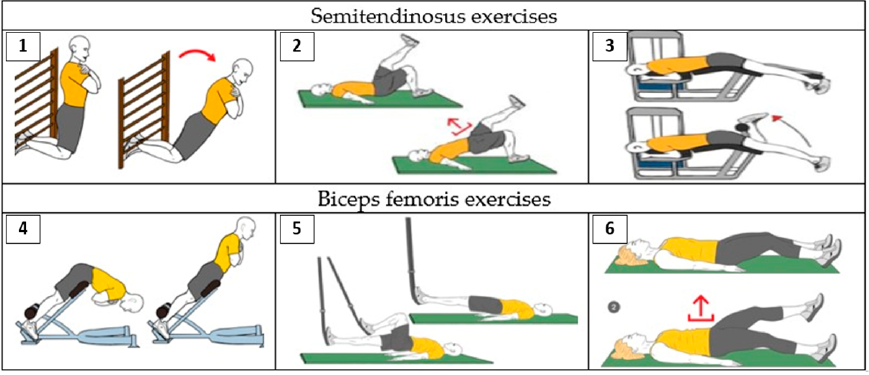
Figure 1. Individual programme 1. Nordic curl, 2. Single-leg bridge, 3. Prone leg curl, 4. Glute-Ham rise, 5. Single-leg bridge with straight leg in suspension, 6. Single-leg bridge with straight leg. The control group did not perform any specific training based on tensiomyography assessments. During the 8 weeks that the experiment lasted, they only did their usual